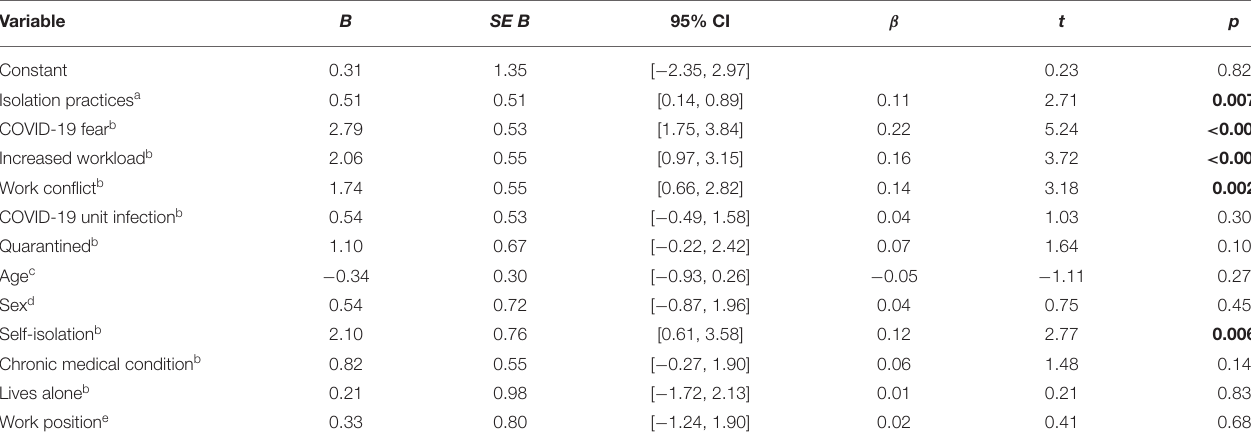
TABLE 11 | Multiple linear regression analysis for worker variables predicting IES-R posttraumatic stress—intrusion score. Variable B SE B